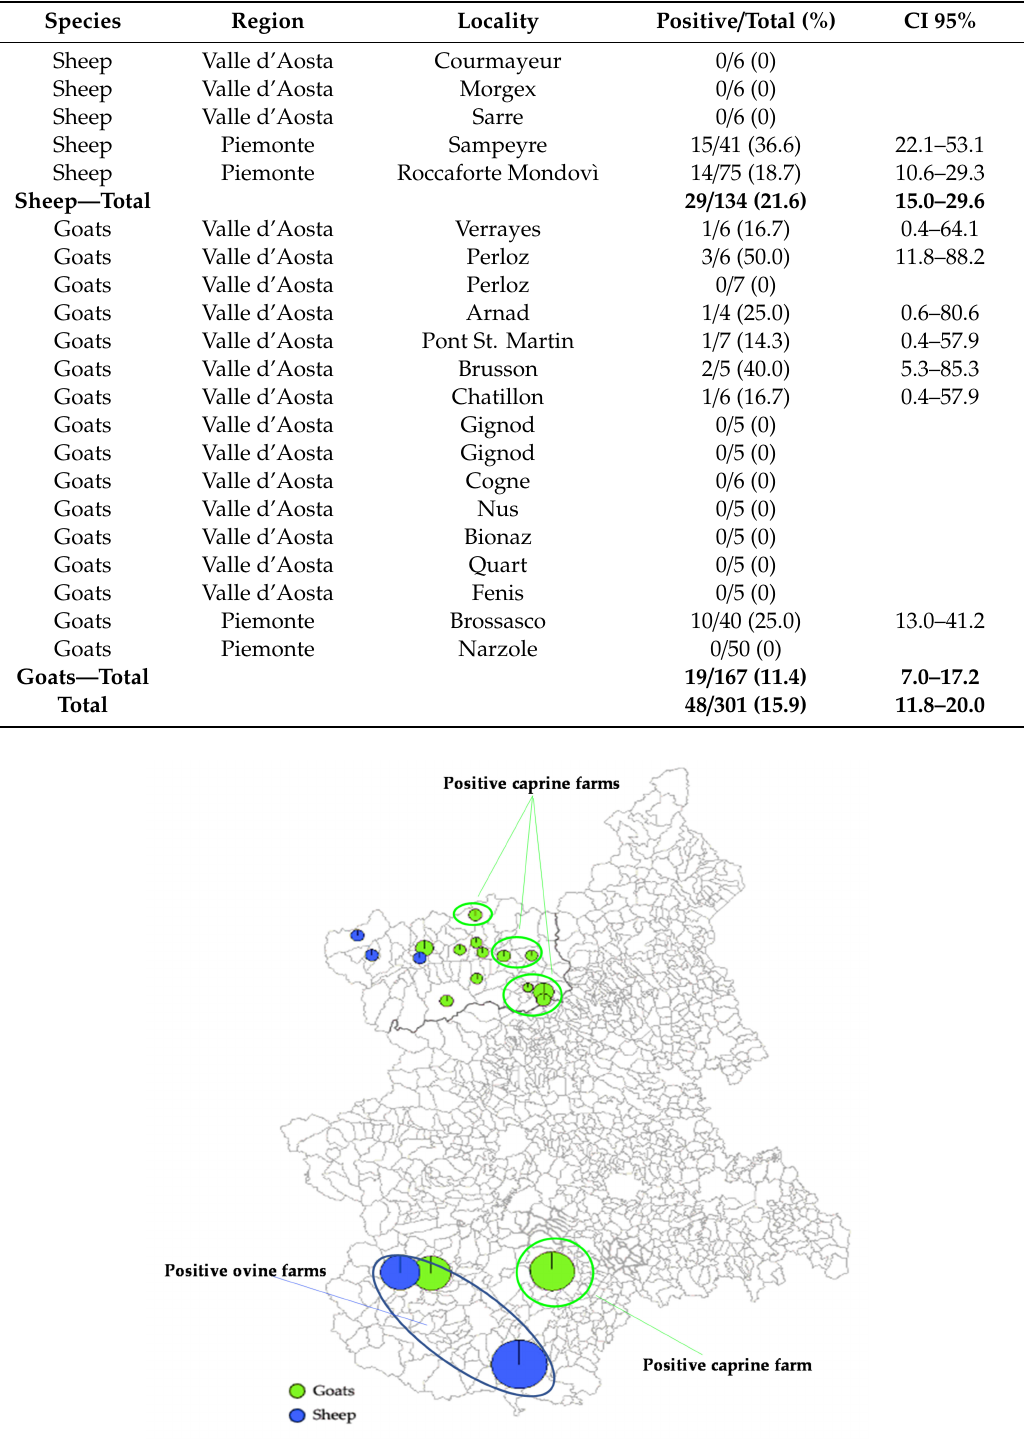
Table 1. Serological prevalence of Hepatitis E virus (HEV) in sheep and goat farms.